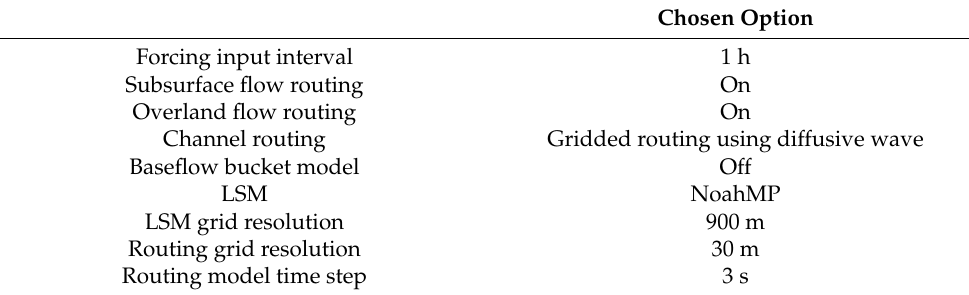
Table 2. WRF-Hydro model configurations.